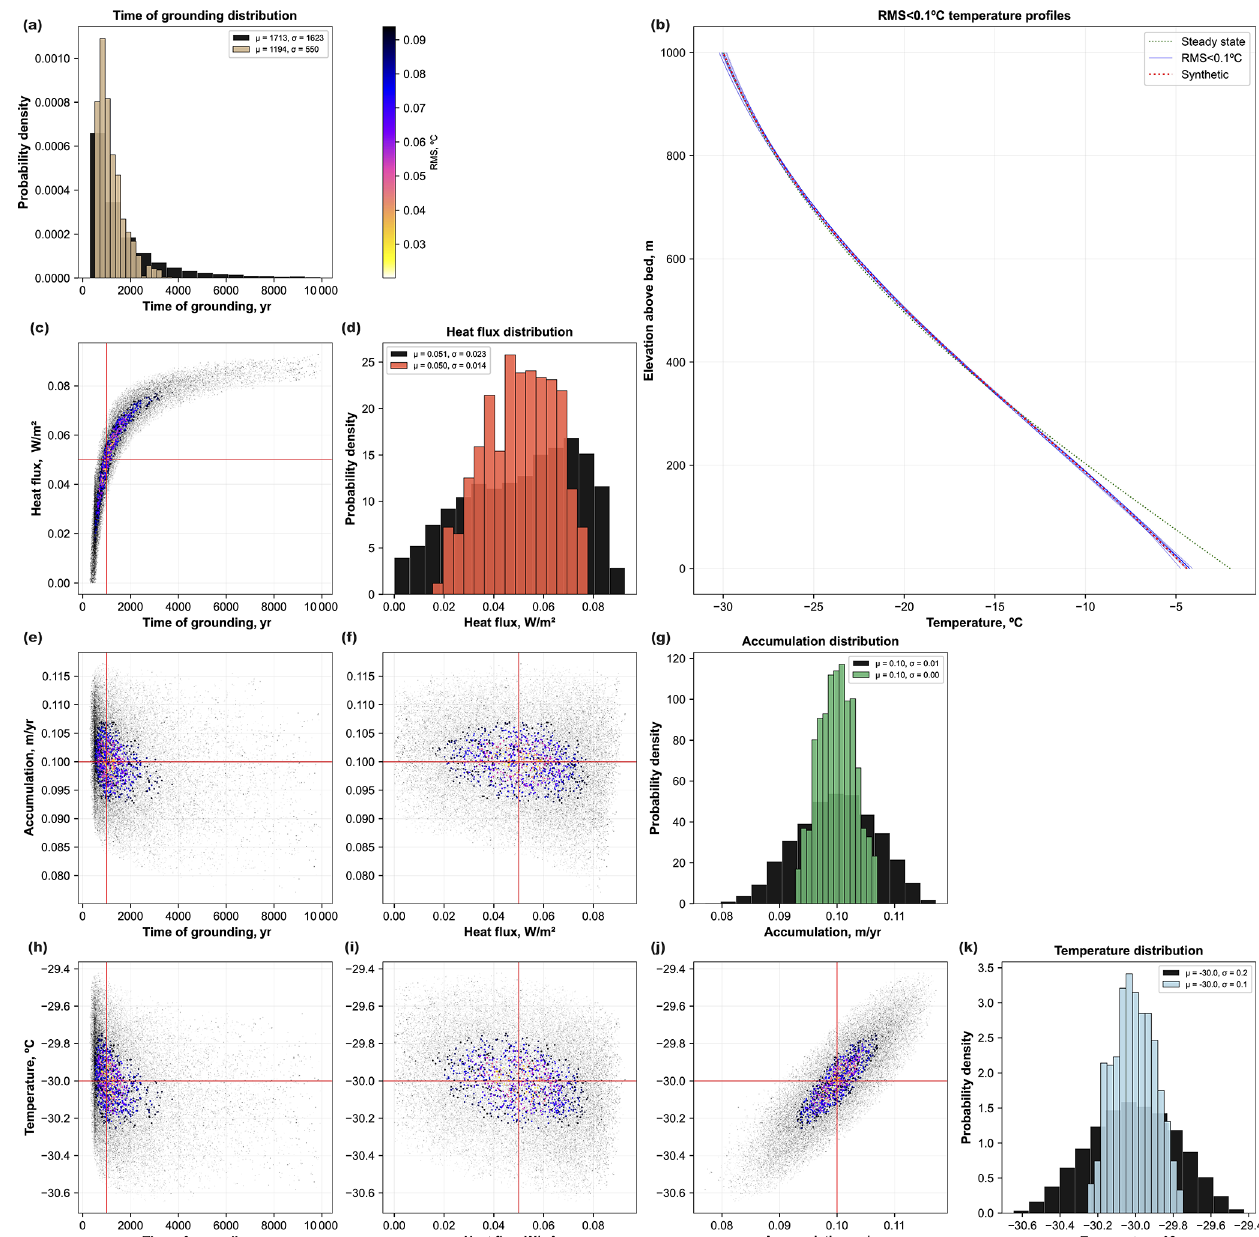
Figure 3. Inversion of the synthetic temperature profile data. Synthetic temperature–depth profile (dotted red line in panel b ) was produced using the prescribed set of parameter values (shown by the intersection of solid red lines in the scatter plots, c , e , f , h – j ). The scatter plots illustrate the random walk in the parameter space: in grey are the tested combinations of parameter values that yielded a less than 0.3 ◦ C rms misfit with synthetic temperature profile, while in colour is the combination of parameter values that yielded best-fit with synthetic profile (i.e. < 0.1 ◦ C rms). The colour of the points indicate the rms. Diagonally placed histograms (a, d, j, k) show posterior distributions for each parameter: black bars show parameter distributions that yielded rms < 0.3 ◦ C rms; coloured bars show distributions of parameter values that yielded best-fit with synthetic temperature profile (i.e. < 0.1 ◦ C rms). Insets in histograms display the mean, µ , and standard deviation, σ , of each distribution. (b) Randomly selected resultant temperature profiles for 0.1 ◦ C rms